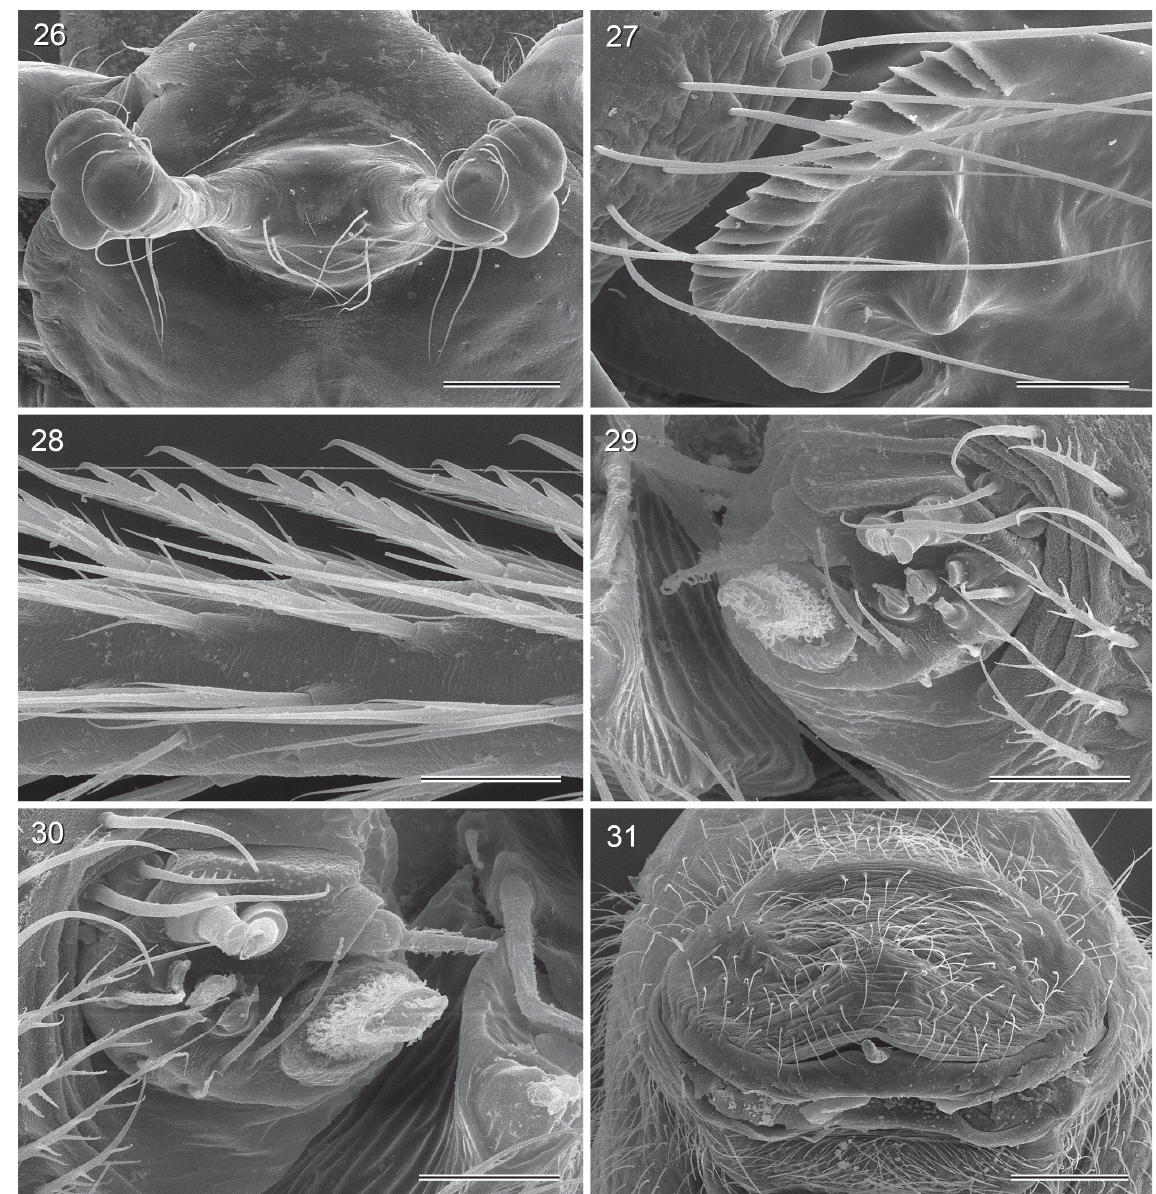
Figs 26–31. Pholcus uludong Huber sp. nov., SeM micrographs (ZFMK, Ar 15695–96). 26 . Male ocular area, dorsal view. 27 . Dorsal process of right procursus. 28 . Comb-hairs on male tarsus 4. 29–30 . Male and female ALS. 31 . Epigynum, ventral view. Scale bars: 26, 31 = 200 µm; 27 = 60 µm; 28–30 = 20